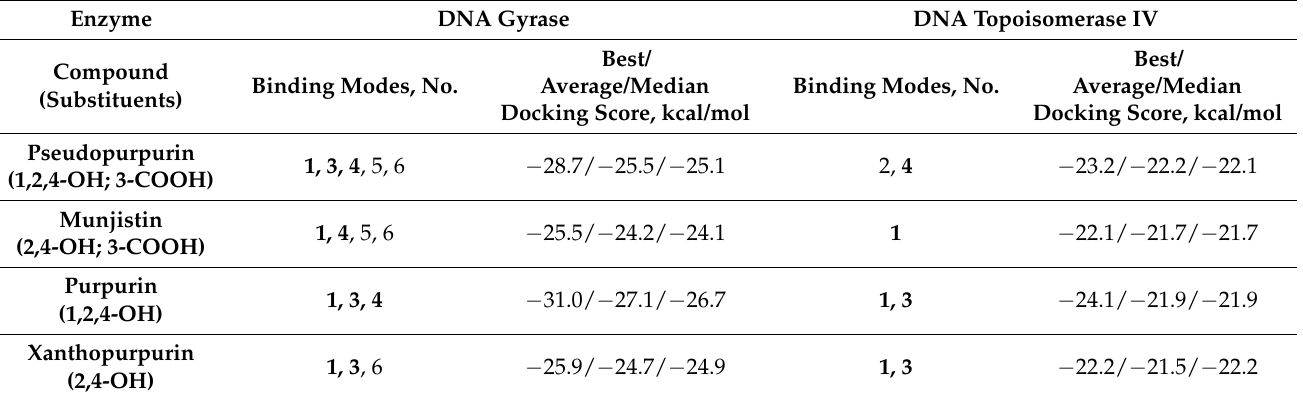
Table 2. Summary of the predicted binding modes and docking scores (best, average, and median) of the studied hydroxyanthraquinones (in ionization states of higher probability) in the docking simulations in DNA gyrase and DNA topoisomerase IV. The BMs shared between the docking outputs of the two targets are